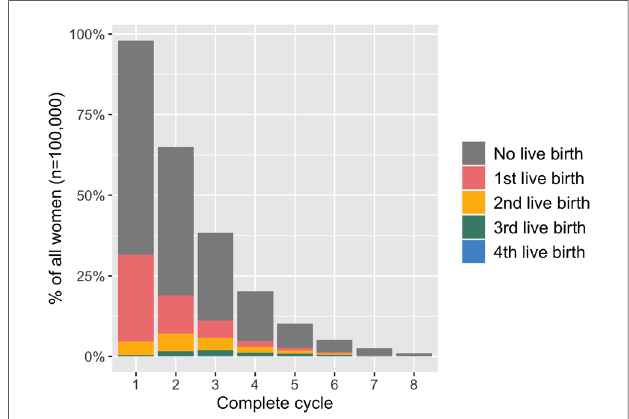
FIGURE 2 Treatment outcomes in 38-39-year-old women strati fi ed by complete cycle. The height of the bar indicates the proportion of all women ( n = 100,000) who started each complete cycle (as de fi ned by undergoing an oocyte pick-up